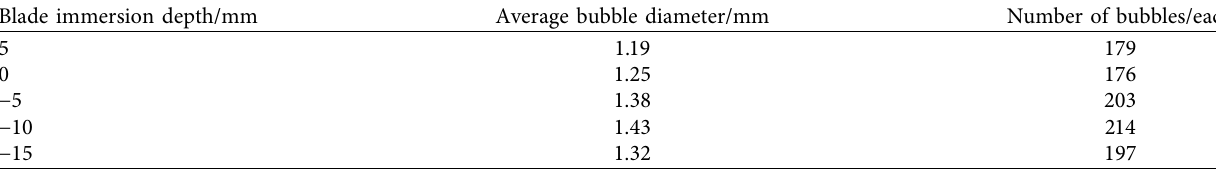
Table 2: Distribution of bubble size at different immersion depths.